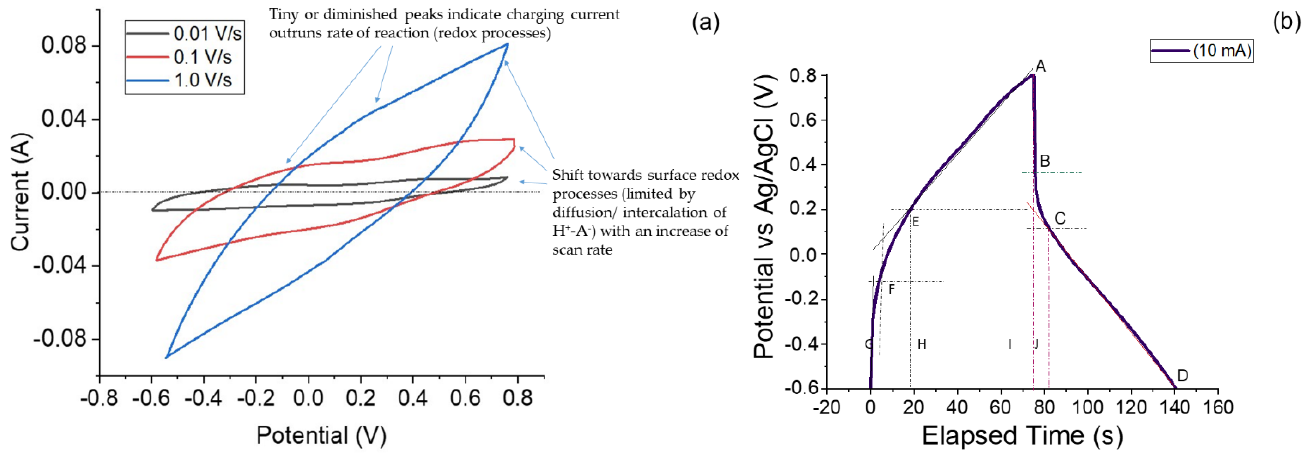
Figure 11. ( a ) Characteristic CV curves at three distinct scan rates showing the charging current outrunning the rate of the redox reactions with an increase in the scan rate. ( b ) Characteristic GCD curve recorded at 10 mA showing a dominance of linear variation of potential with time.